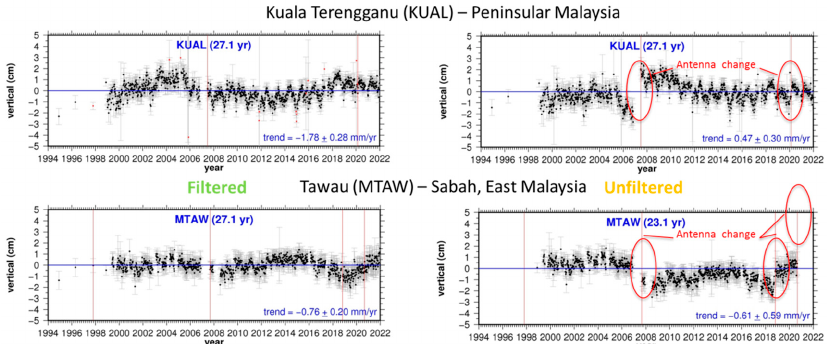
Figure 9. Filtered and unfiltered (detrended) vertical GPS position time series (1994–2021) for stations KUAL (Kuala Terengganu, Peninsular Malaysia) and MTAW (Tawau, Sabah, East Malaysia. The left panel shows the vertical position time series with all antenna-change-related position jumps removed. The single linear trend estimates are shown in blue.